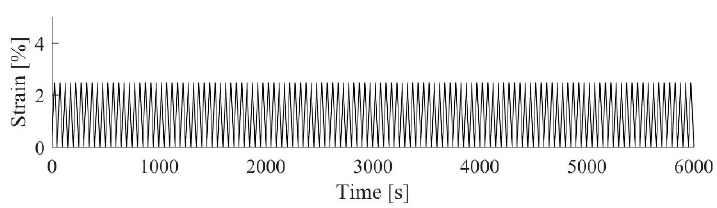
Figure 7. Loading protocol 4 (frequency 0.02 Hz) used for specimen S 41 .